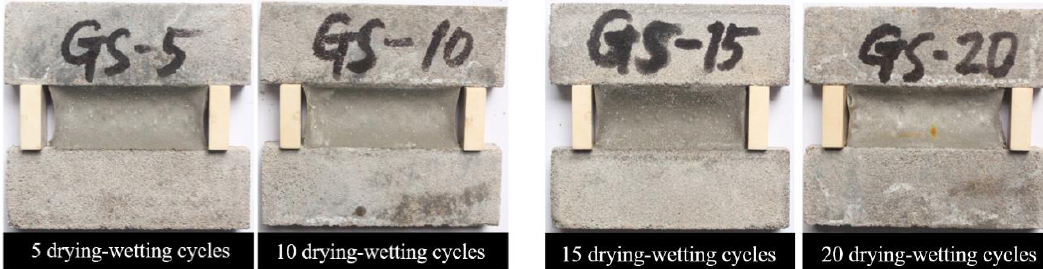
Figure 7. Fixed elongation morphology characteristics of PCFC under different drying–wetting cycles.